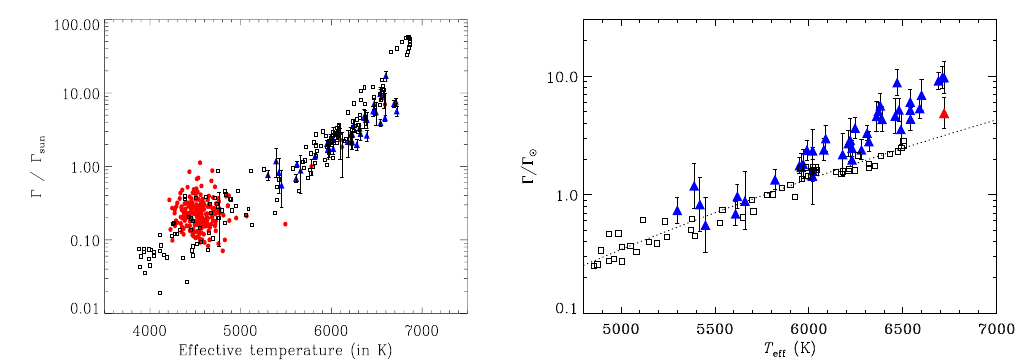
Figure 11: Comparison of CoRoT (red-filled circles) and Kepler (blue-filled triangles) linewidths Γ (Appourchaux et al. , 2012) at maximum mode heights, in units of the solar linewidth Γ ≃ 0 . 95 𝜇 Hz, with theoretical stability calculations (open rectangles) as a function of surface temperature 𝑇 eff . The 3- 𝜎 error bars are indicated. Left panel: Results using Grigahc´ene et al. ’s time-dependent convection model, who obtained a power-law fit, Γ ∝ 𝑇 10 . 8 , to the model results (open rectangles). Image reproduced with eff permission from Belkacem et al. (2012), copyright by ESO. Right panel: results are shown from Houdek et al. (in preparation) using Gough’s (1977a,b) time-dependent convection model. In this panel only Kepler data (blue-filled triangles) are shown and only from a single group (IAS) of mode fitters using a maximum likelihood estimator. The dotted curve is a power-law fit, Γ ∝ 𝑇 7 . 5 , to the model results (open rectangles). eff The red-filled triangle indicates half the measured linewidth value for the Kepler star KIC